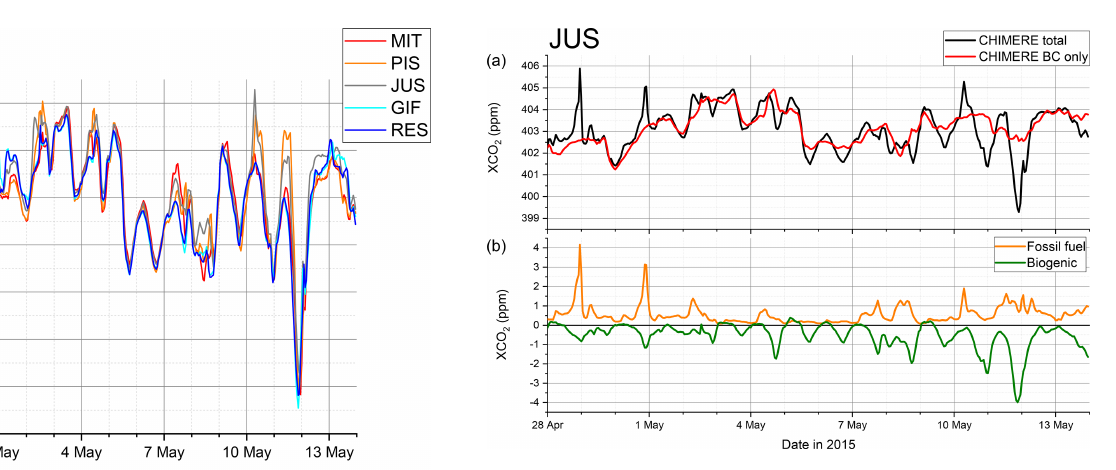
Figure 6. Time series of XCO 2 and related fluxes for JUS. Panel (a) provides a comparison of modelled total XCO 2 and XCO 2 varia- tions due to changes in boundary conditions (BC only). Panel (b) shows the contribution of the different flux components, namely fossil fuel CO 2 emissions and biogenic